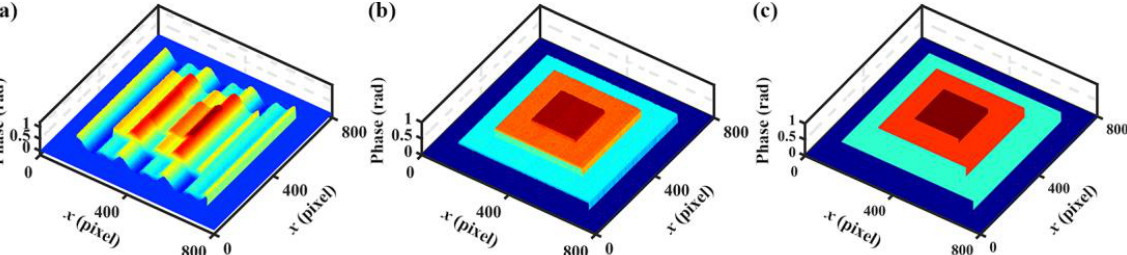
8 of 13 Figure 4. Results of the simulated spheres: ( a ) absolute phases recovered without corrections; ( b ) phase map obtained only with the histogram equalization; ( c ) phase map obtained with the whole proposed method; and ( d – f ) error maps corresponding to ( a – c ), respectively. Unit: rad. Secondly, a single, continuous, step height object was generated. The simulated pa- rameters were the same as mentioned above. The necessity of spline fitting in our method was validated in the first simulation. In this simulation, the effectiveness of the proposed method in dealing with objects with cliff edges was verified. Similarly, we recovered the phase map using the normal unwrapped algorithm and the proposed method. Figure 5a shows the absolute phase obtained without nonlinear error elimination, and its surface had serious ripple errors. In contrast, the results recovered with the proposed method had smooth surfaces, as illustrated in Figure 5b. The ground truth of the step height is shown in Figure 5c. Figure 6 illustrates the cross-section of the recovered results and the ideal phase of the step height. The line marked in red is the distorted phase, and the information